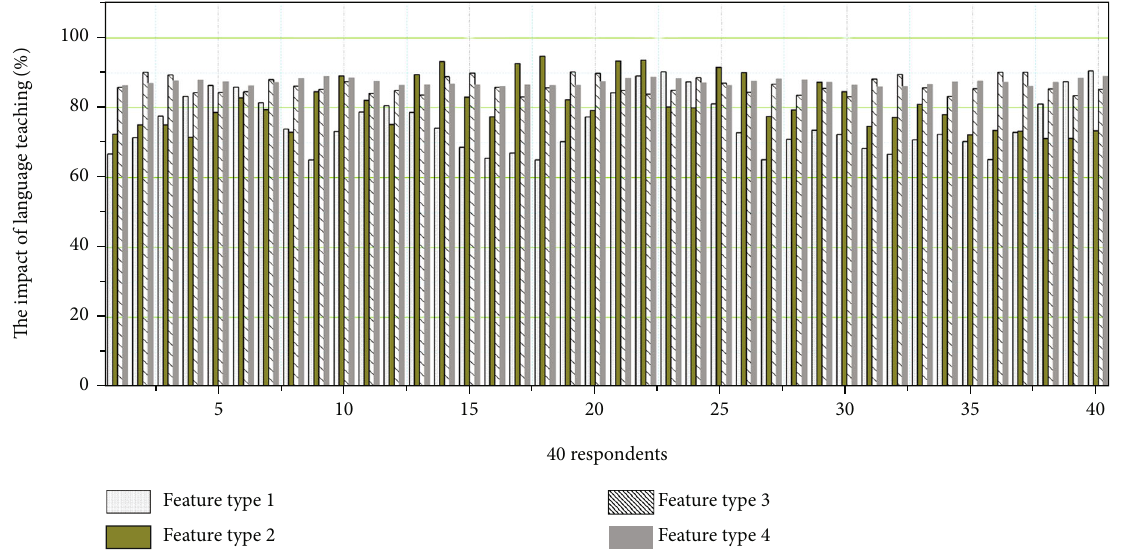
Figure 5: The in fl uence of the types of vocabulary emotion color correction features on language